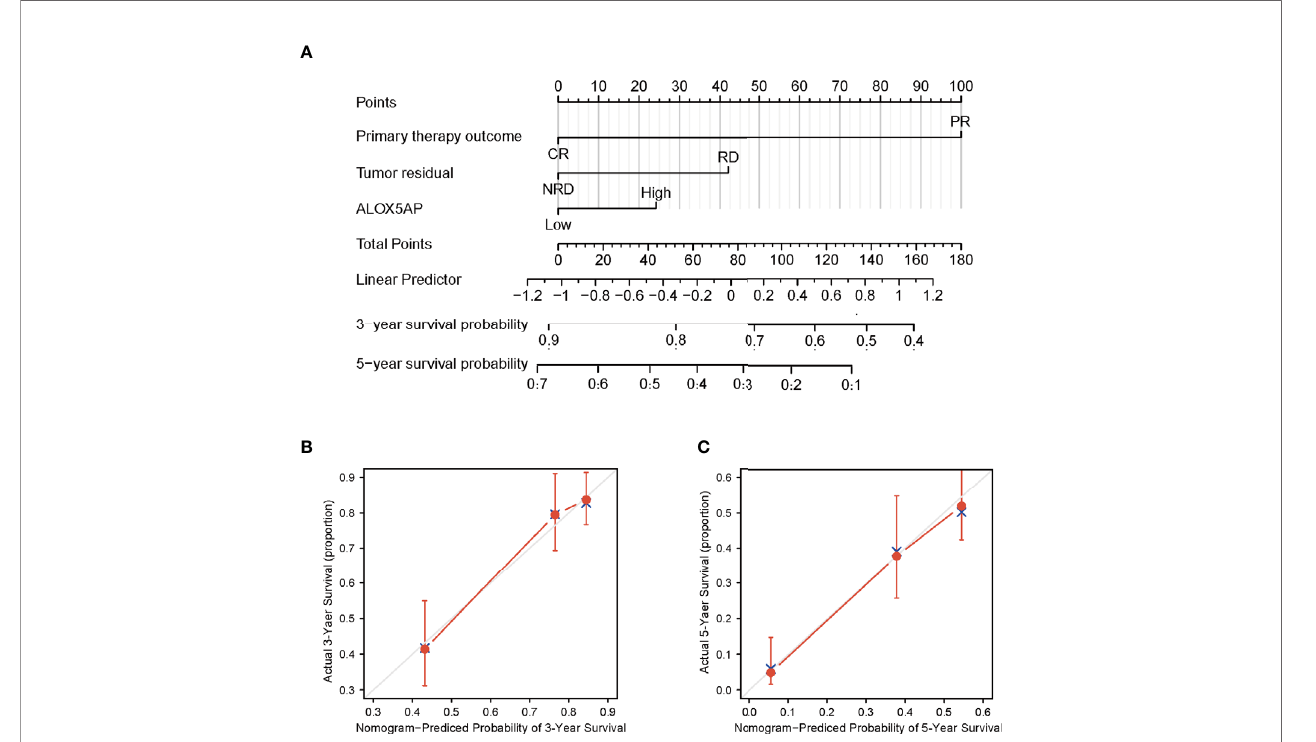
FIGURE 4 | Construction and performance validation of ALOX5AP based nomogram for SOC patients. (A) Nomogram for predicting overall survival for ovarian cancer patients. Each predictor is assigned a score on each axis. Compute the sum of points for all predictors and denote this value as the total points. (B, C) Calibration curve of the nomogram for predicting 3- and 5-year OS in the TCGA-OV